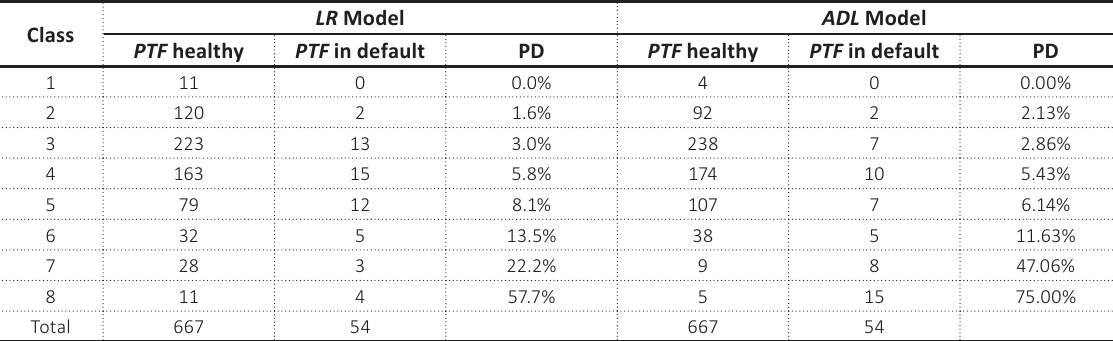
Table 1. The PD per class of two models